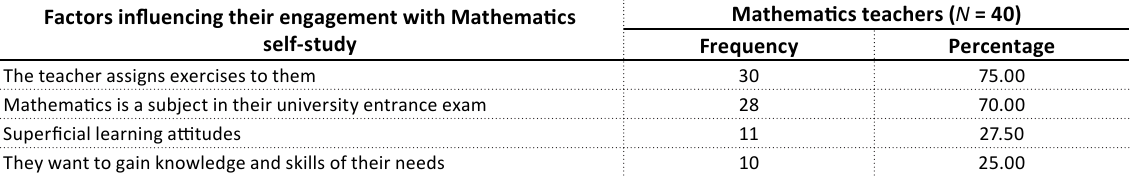
Table 8. Teach ers’ evaluation of factors influencing students’ self-study of Mathematics